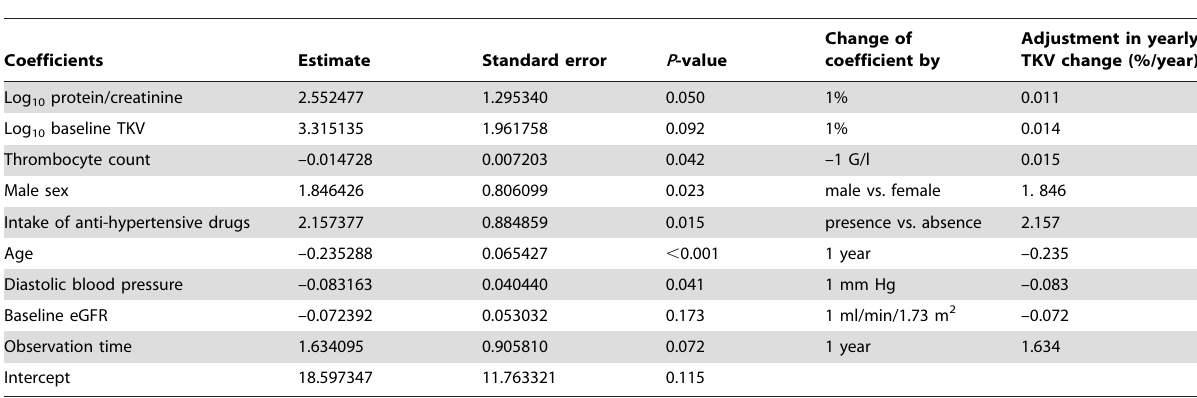
Table 5. Linear regression model with 96.4% windsorized yearly TKV change as dependent